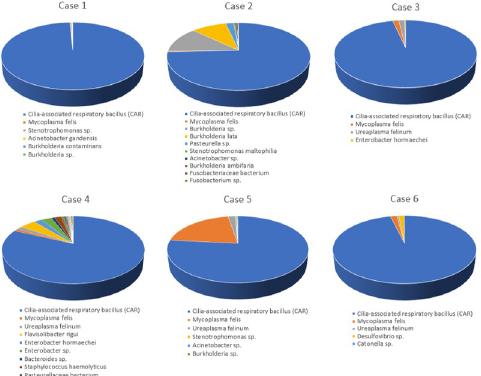
Fig 2. Pie charts of the percentage reads of various constituent 16S rDNA sequences in NGS analysis of feline BALF specimens from cats with lower airway disease and where Filobacterium felis was the preponderant organism. For consisteny, F . felis reads are shown in navy blue, Mycoplasma felis reads are shown in orange and Ureaoplasma felinum reads are shown in grey. For simplicity, bacteria with reads less than 0.2% were not illustrated.